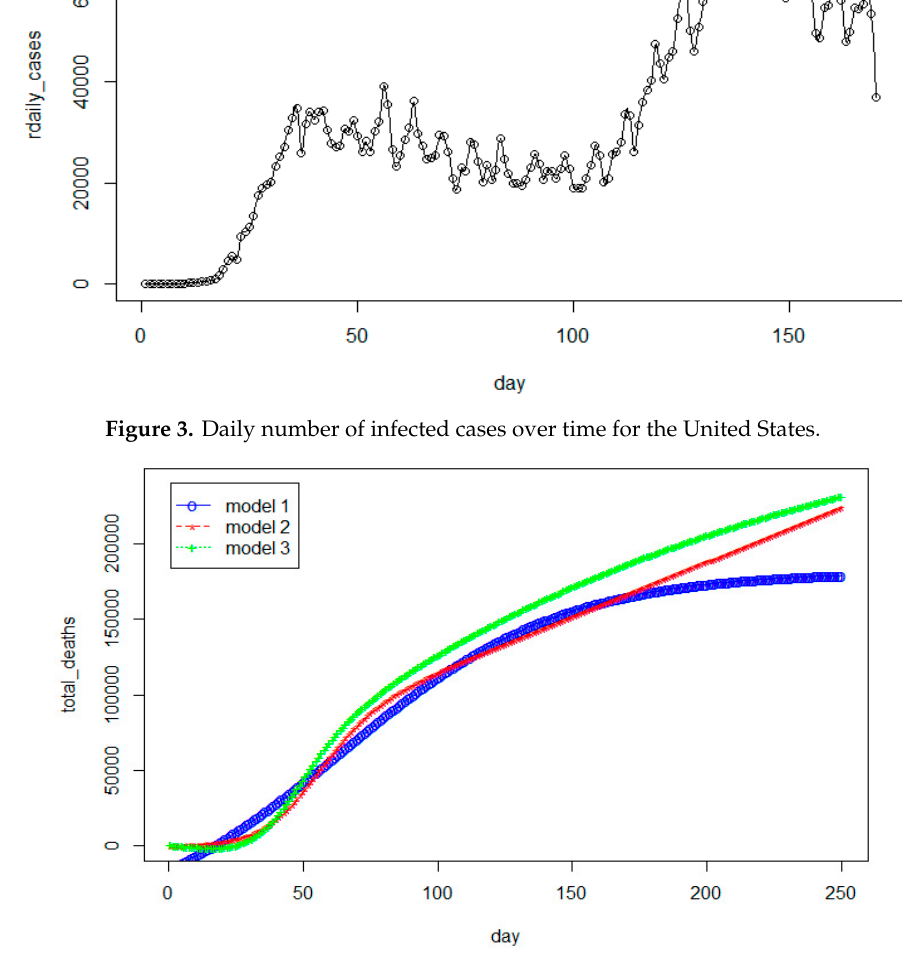
Figure 4. The estimated cumulative number of deaths over time for the United States.